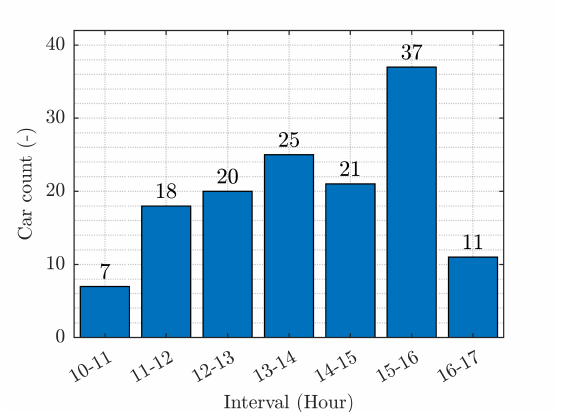
Figure 7. Traffic density on the local road between 10:00 and 17:00.